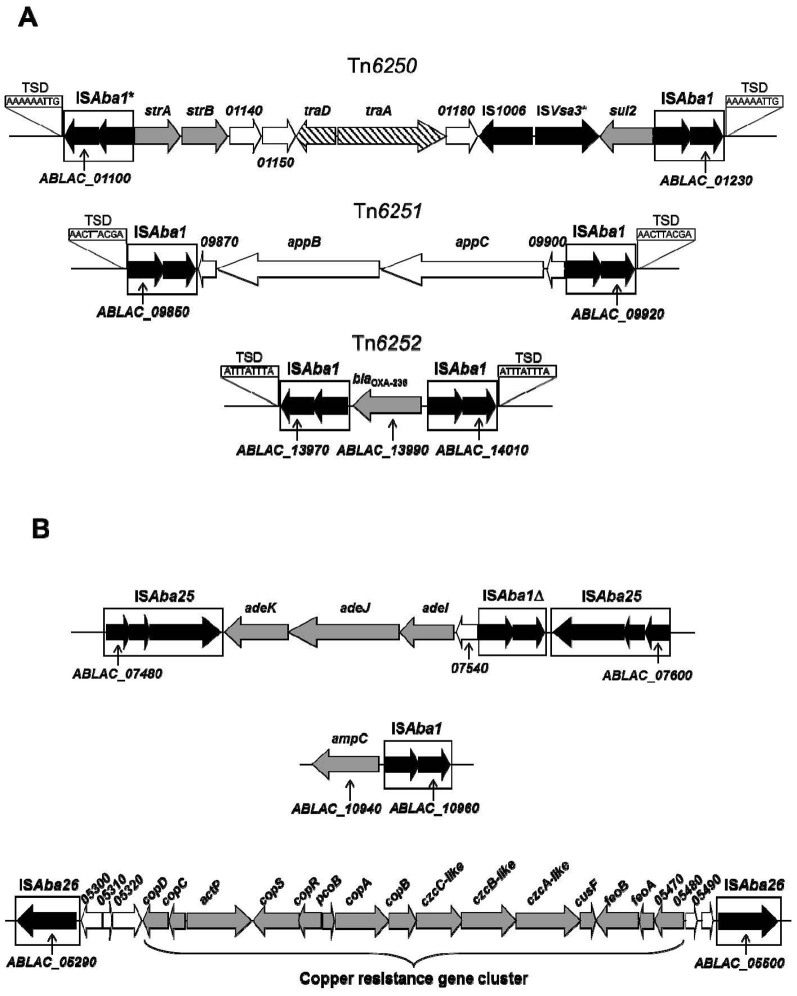
Select examples of insertion sequences and transposons in LAC-4 genome.Direction of transcription of genes is shown by the direction of the arrows. Dark arrows denote ORFs for transposase genes. Gray shaded arrows mark genes potentially conferring resistance to antimicrobial agents or copper. Genes involved in conjugation (tra genes) are marked by striped arrows, while genes coding for proteins of unknown or other functions are shown in open arrows. Due to space limitation, certain loci are labeled with abbreviated locus-tags without the full name (e.g., ABLAC_01150 is abbreviated as 01150). Sizes of genes and intergenic distances are not drawn to scale. (A) Composite transposons (Tn6250, Tn6251 and Tn6252) formed by ISAba1 elements. Target site duplication (TSD) of 9 bases in length was noted only next to the external inverted repeats (facing outwards). An asterisk (*) next to ISVsa3 indicates the partial nature of the element (likely not functional). (B) Gene or gene clusters flanked by IS elements. A delta symbol (Δ) next to ISAba1 denotes an apparently nonfunctional copy of the element.